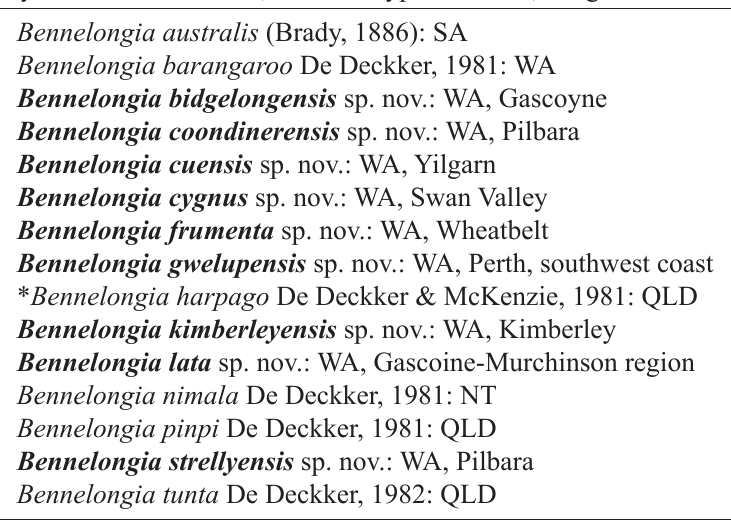
Table 2. Species presently described in Bennelongia and their distribution (species in bold are newly described here) . Only certain distributions, based on type localities, are given here. * = type